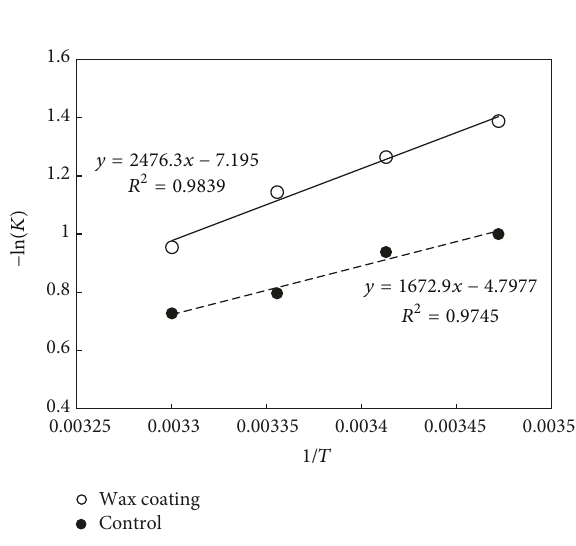
Figure 2: − ln (𝑘) versus 1/𝑇 for control (A) and wax treated (B) cucumbers.